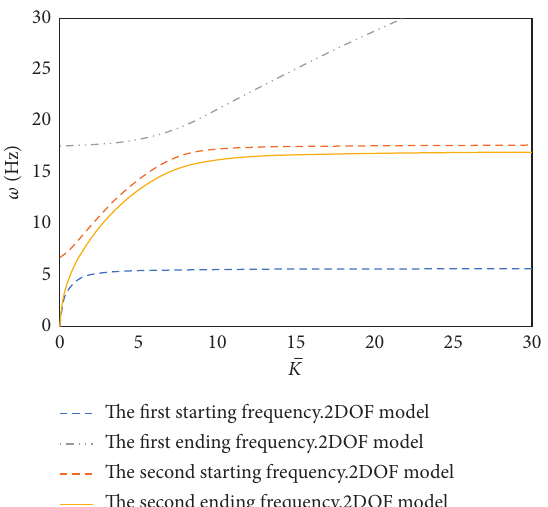
Figure 18: The effect of I parameter on bandgap for the 2DOF